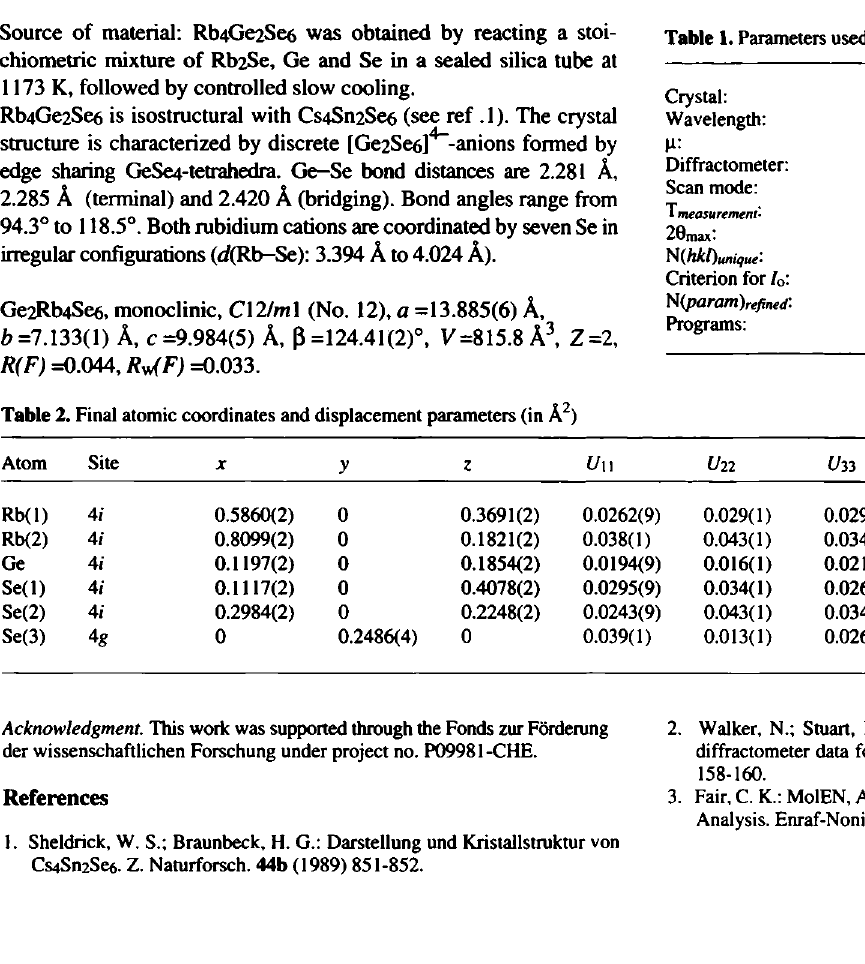
Table 1. Parameters used for the X-ray data collection